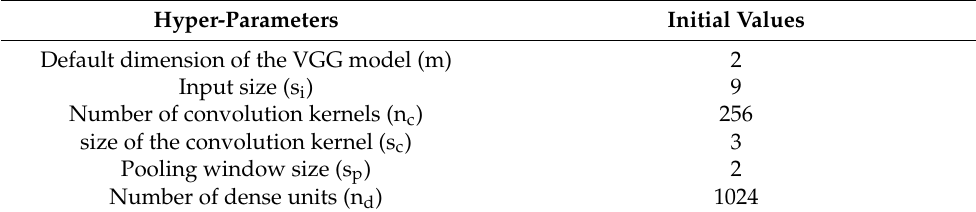
Table 3. Hyper-parameters involved in the VGG model.